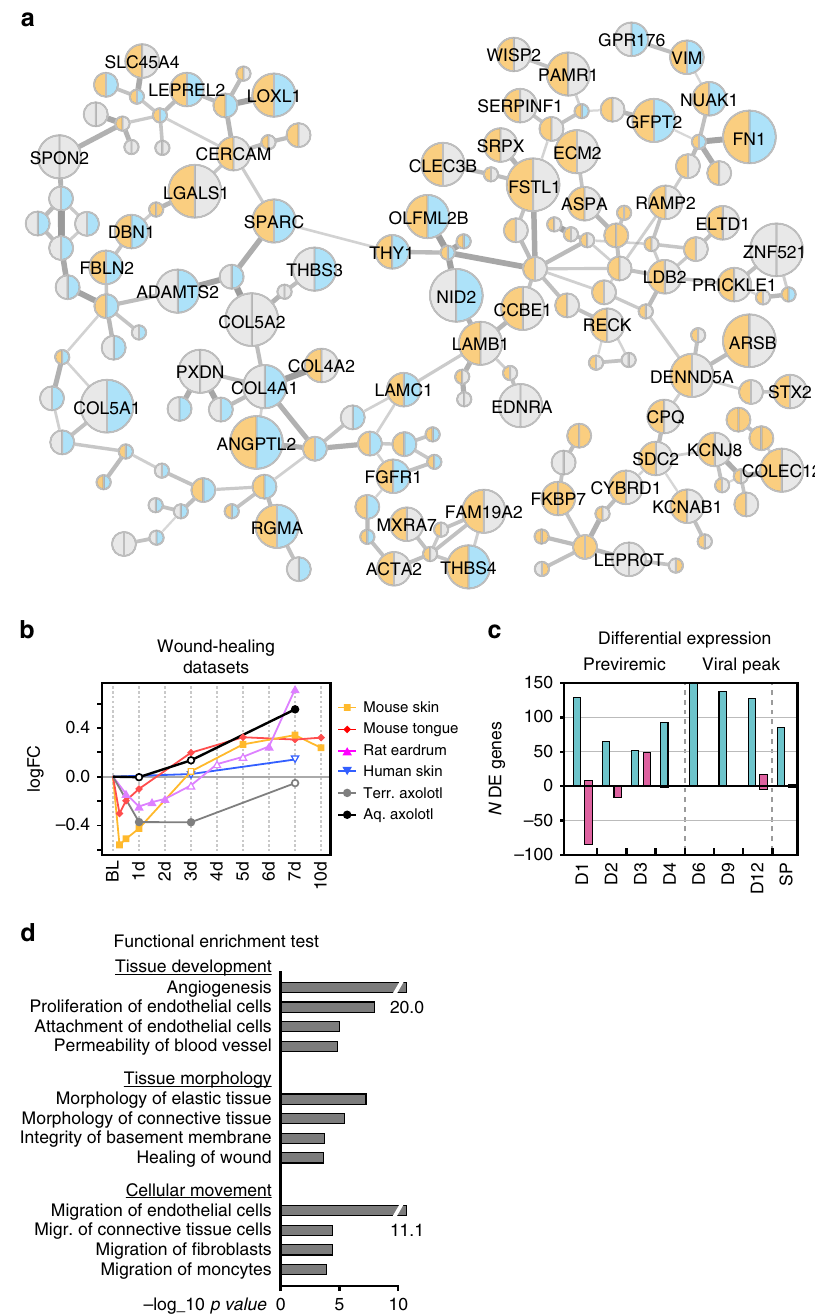
Fig. 4 Wound Healing Network analysis revealed by CGSA. a Wound healing co-expression network. Node colors indicate up or downregulation (orange or blue, respectively) at D1 post inoculation in AGMs (left side of node) and RMs (right side of node). Node sizes represent the number of wound healing datasets where the gene is DE. Interaction thickness represent the weight, inherited from the Acute SIV Co-Expression Network. b Average log fold change values of Wound Healing Network genes from each wound healing reference dataset. Filled spots indicate signi fi cant change from baseline. Source data are provided as a Source Data fi le. c Numbers of up- and down genes in Wound Healing Network at each time point in AGM (teal) and RM (pink). d Functional enrichment analysis of Wound Healing Network genes, sorted into three biological